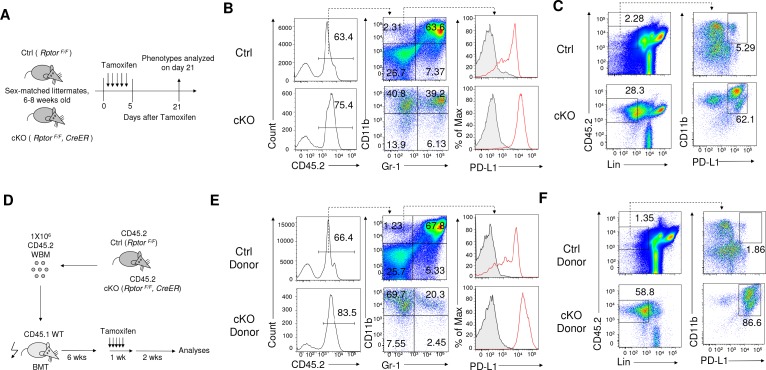
Tamoxifen induced conditional deletion of Rptor in hematopoiesis also led to massive accumulation of IMLECs.(A) Schematic of experimental design. Sex-matched 6–8 weeks old Ctrl (Rptor
F/F) and cKO (Rptor
F/F, CreER) mice were treated with Tamoxifen for five consecutive days. The phenotypes were analyzed 3 weeks after the first treatment. (B) Representative flow cytometric analysis of myeloid cells from Ctrl and cKO mice BM by CD11b, Gr-1 and PD-L1. (C) Rptor deletion caused expansion of Lin- (B220- CD3- Ter119- NK1.1- Gr-1- F4/80- CD115-) CD11b+ PD-L1+ IMLECs in BM. (D) Schematic of experimental design. CD45.2+ Ctrl BM and cKO BM were transplanted into lethal dose irradiated CD45.1+ recipient mice. Tamoxifen treatment of recipient mice was started 6 weeks after fully reconstitution of donor-derived cells. The phenotypes were analyzed 3 weeks after the first treatment. (E, F) Representative flow cytometrical profiles of donor-derived CD45.2+ Myeloid cells (E) and IMLECs (F) in BM of recipient mice are shown as in (B) and (C), respectively.